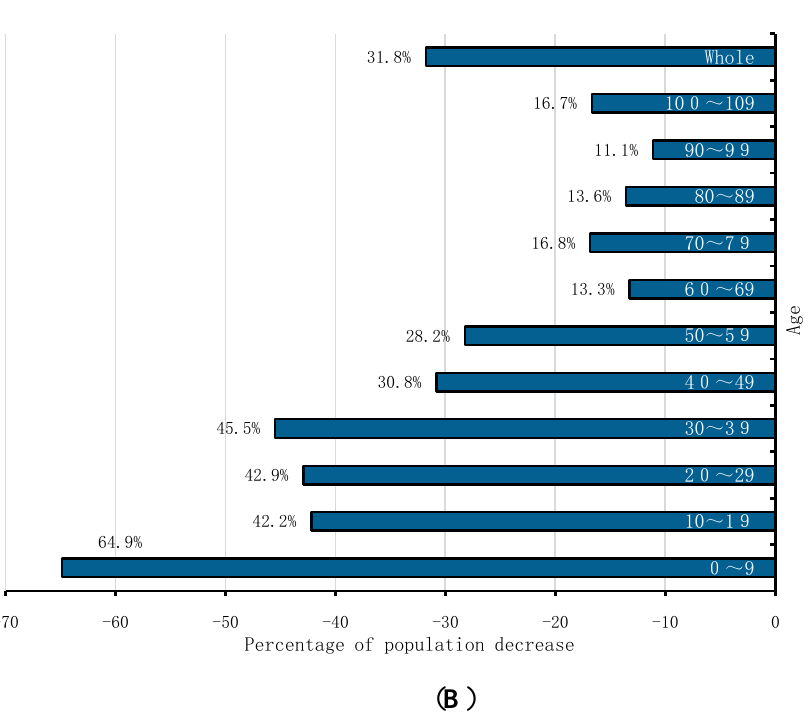
Figure 4. Comparison between Labor Force Populations in Minamisoma before and after the Fukushima Accident. Source: Statistics Department of Information, Policy Division of General Affairs Office of